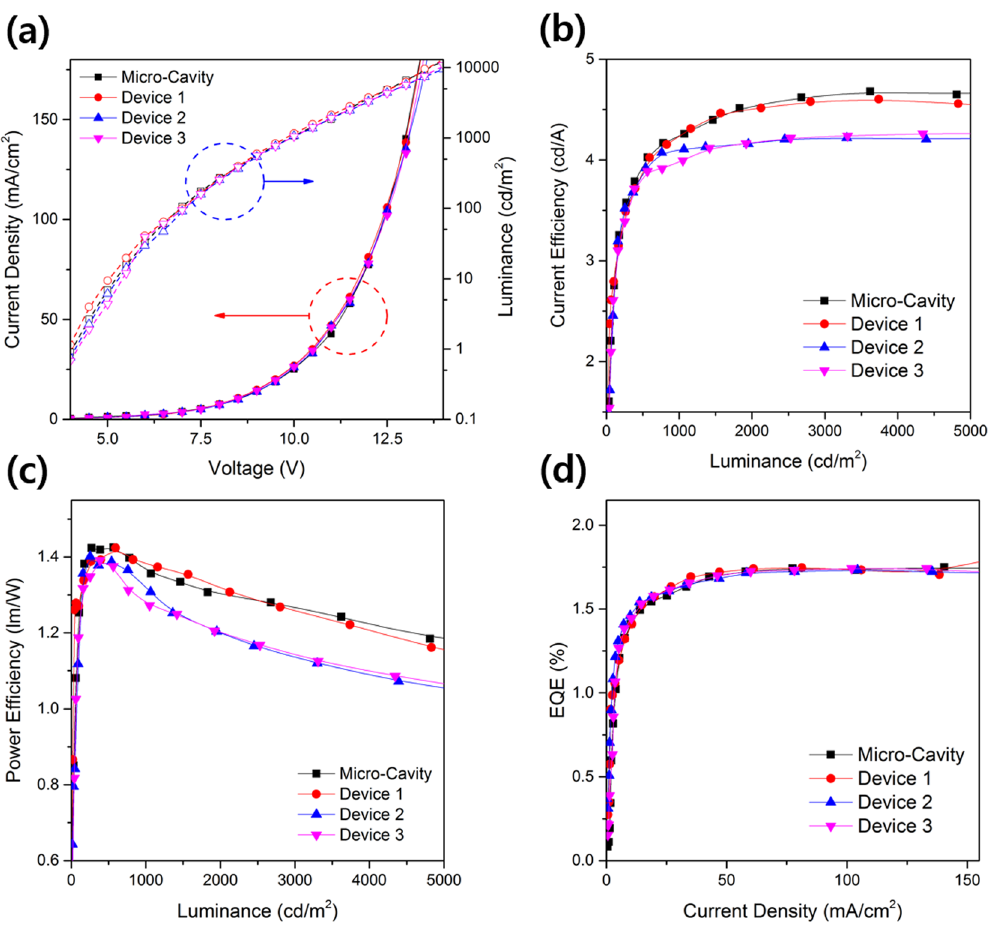
Figure 5. EL characteristics of MC-OLEDs with diffusion layers: ( a ) current-density–voltage-luminance, ( b ) current-efficiency–luminance, ( c ) power-efficiency–luminance, and ( d ) EQE–current-density